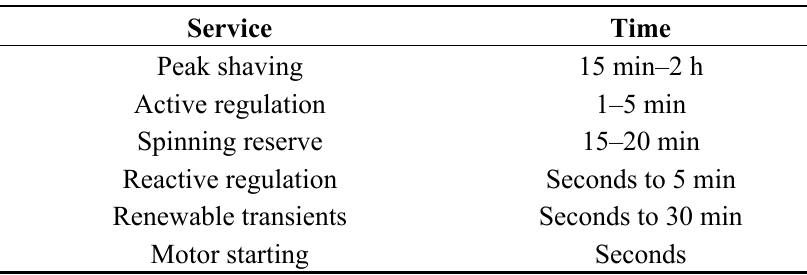
Table 2. Duration of V2G